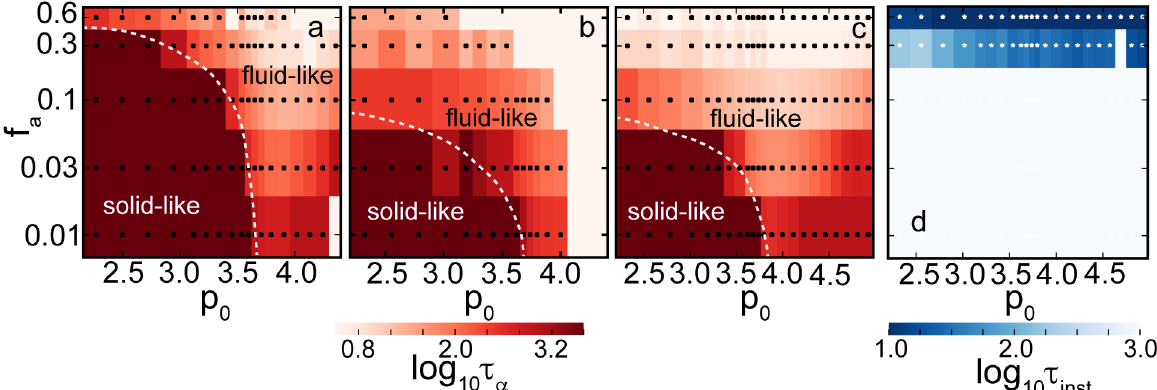
Fig 7. Phase diagrams of the AVM. Panels (a), (b) and (c): α − relaxationtime τ α determinedfrom the self-intermediate scattering function, Eq (21). These plots indicate that it is possibleto initiate cell intercalation events by changing values of p 0 or active driving. High values of τ α (dark regions) correspond to the solid-like (glassy) phase where T1 events are suppressed. (a) Fixed system with ¼ 0 : 01 . (b) Open system with Γ = 1, t (cid:0) 1 ¼ 0 : 01 and boundary line tension λ = 0. (c) Open system with Γ = 0.1, t (cid:0) 1 ¼ 0 : 1 and Γ = 1 and t (cid:0) 1 r r r boundaryline tension λ = 0.1. All systems are solid-like at low p 0 and low driving f a . The critical p 0 = 3.81 is the same in (a), (b) and (c), but the opensystem becomesliquid-likeat much lower values of active driving. Lowering Γ also lowers this transition point. The dashed white line represents a rough boundary betweensolid-likeand fluid-likebehaviour. (d) Characteristic time scale τ inst neededto reach the boundaryinstability, determined from reachinga thresholdboundary length (see text), for the same parameters as (c). Sufficiently high driving alwaysleads to an